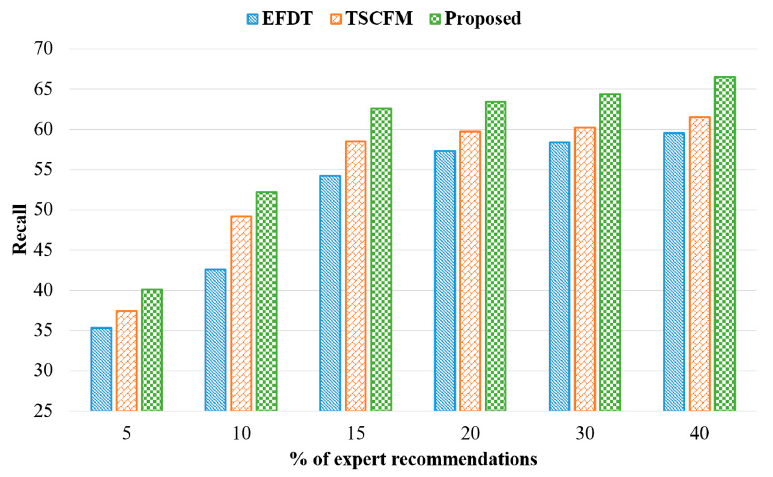
Figure 9. Recall according to the number of expert recommendations.